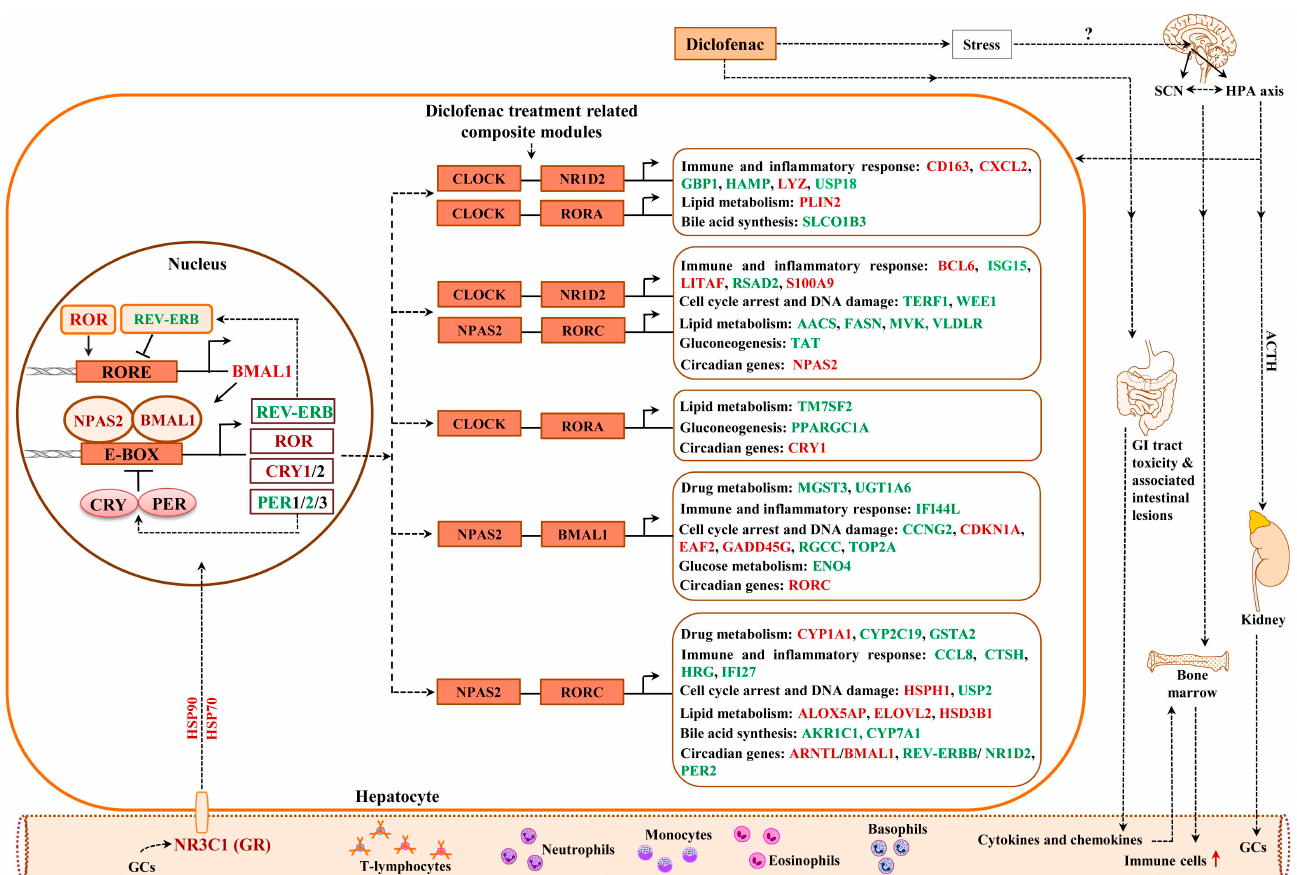
Figure 12. Liver clock regulatory gene network in response to diclofenac treatment. Drug treatment resulted in perturbed liver clock activity. Shown are composite modules of circadian transcriptional regulators at promoters of hepatic DEGs coding for immune response, inflammation, metabolism, cell cycle arrest and DNA damage. Genes marked as red are significantly up-regulated; those given in green are repressed in expression. SCN = suprachiasmatic nucleus, ACTH = adrenocorticotropic hormone, GC = glucocorticoids, HPA axis = hypothalamic pituitary adrenal axis.